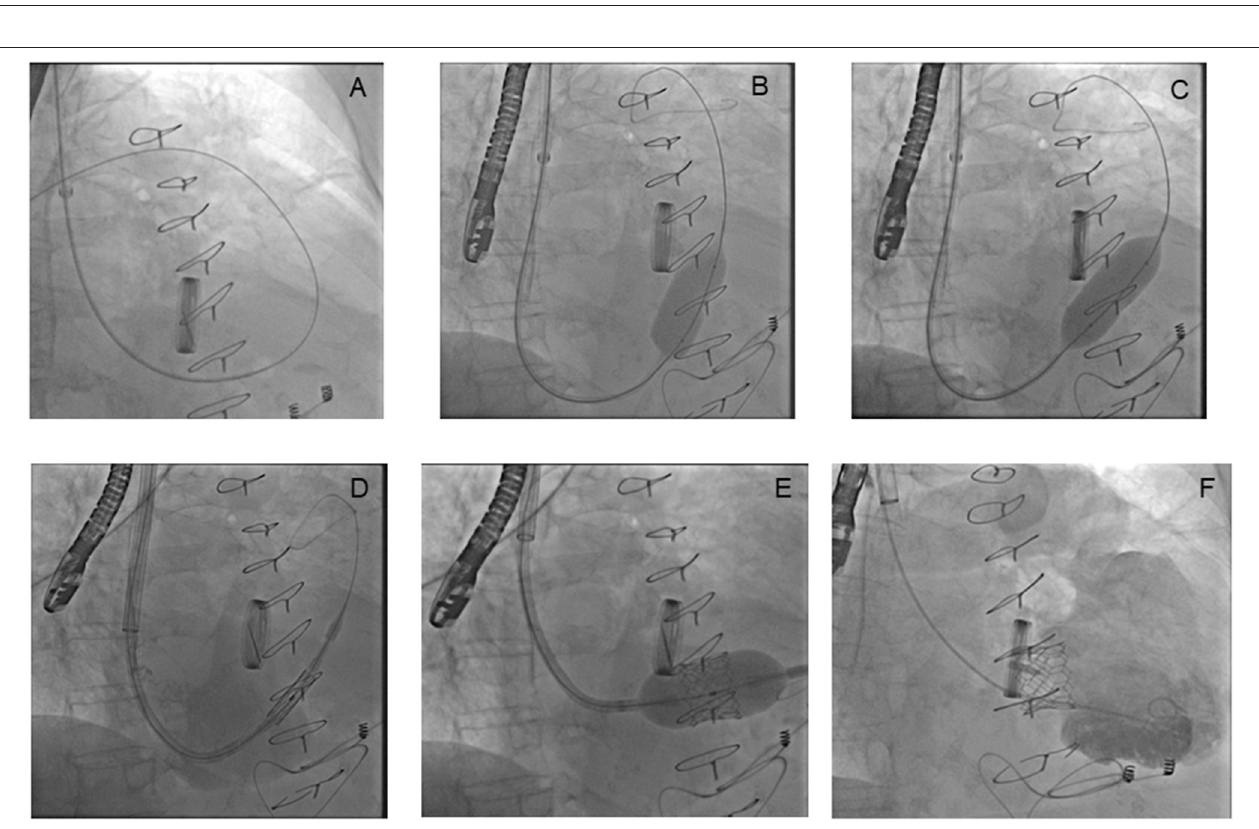
FIGURE 2 | The implantation of an aortic balloon expandable biological valve into a degenerated tricuspid biological prosthesis. A Swan Ganz catheter with an angiographic 0.035’ wire crosses the tricuspid degenerated prosthesis (A) . A balloon valvuloplasty is performed, even if no mandatory in valve in valve procedure. The first balloon inflation shows a residual stenosis (B) , the second inflation shows a successful balloon expansion. The valvuloplasty is also performed to confirm the degenerated bioprosthesis size (C) . An aortic balloon expandable biological valve, a device normally used for aortic valve replacement, crosses the tricuspid degenerated prosthesis (D) . The guidewire is placed in right ventricle to achieve a perfect alignment between transcatheter valve and degenerated bioprosthesis despite the horizontal right chamber axis. The valve is deployed using a 3D transesophageal echocardiography (TEE) reconstruction and right atrial angiography to control the release (E) . The final right ventricular angiography shows no residual regurgitation after valve in valve implantation (F) .